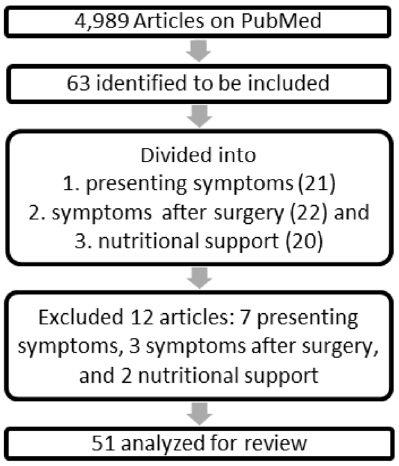
Figure 1. Literature search and study.